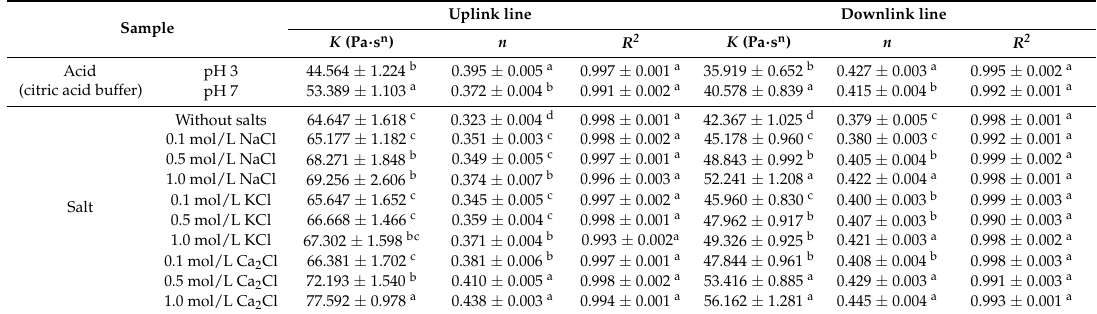
Table 2. Power law parameters of the LRS/KGM mixed system in acid or salt solutions. Uplink line Downlink Sample